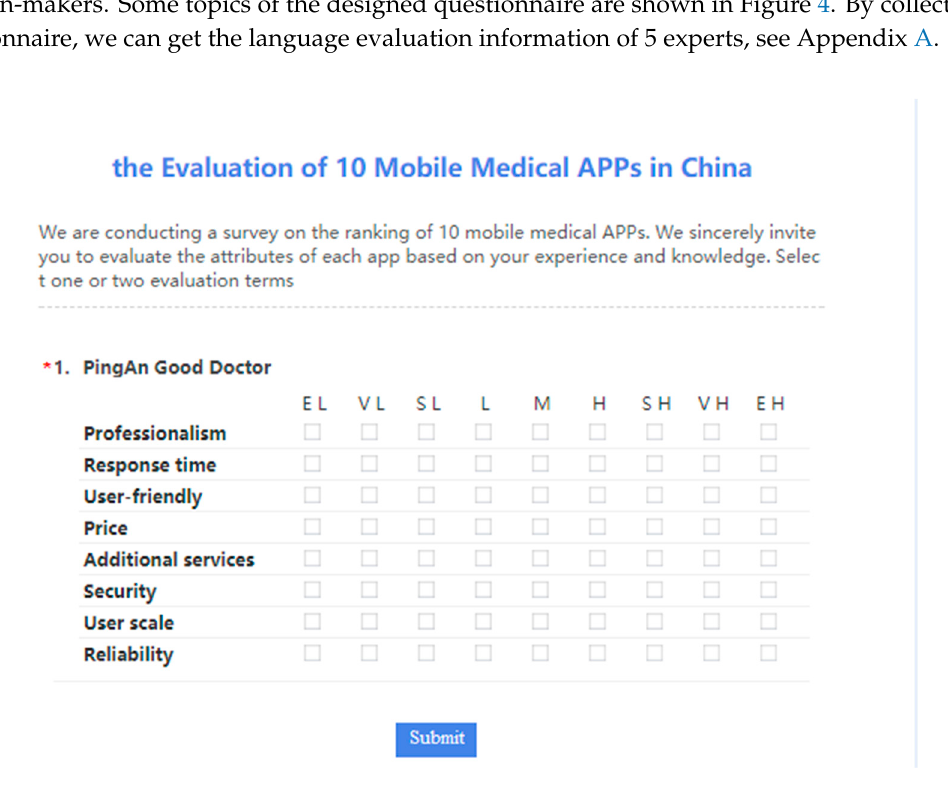
Figure 4. Some topics in the designed questionnaire based on Non-uniform Multiplicative Linguistic Evaluation Scale (MLES).